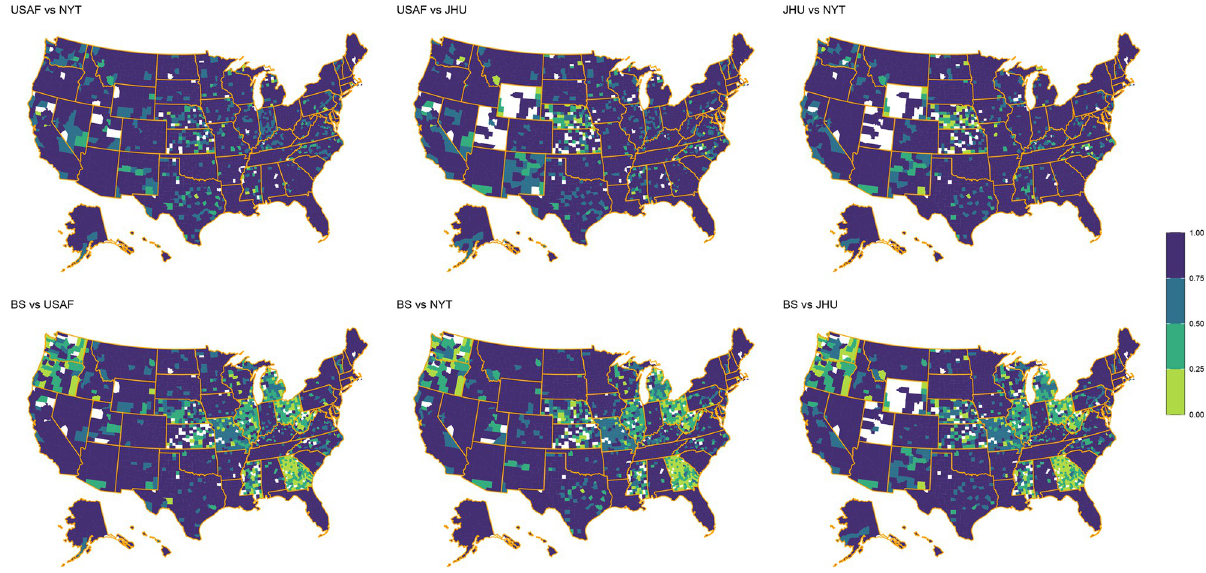
Fig 3. Provides the reliability within each county for the number of COVID-19 deaths using the reliability categories proposed by Cicchetti and Sparrow. Darker (1.00) to lighter (0.00) color indicates more to less